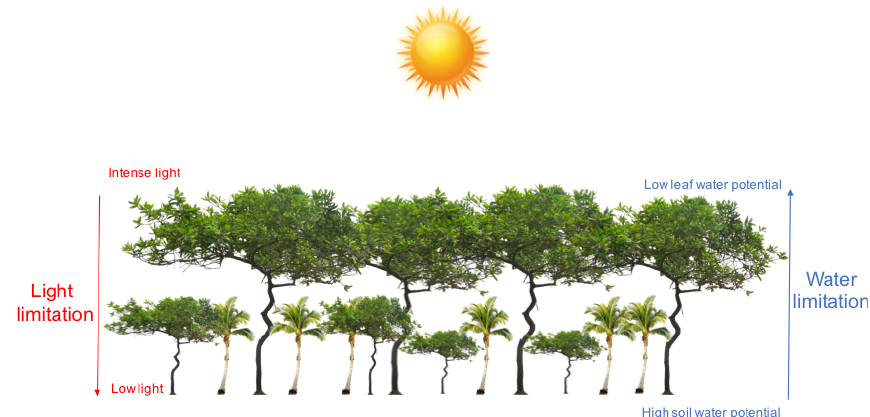
Figure 10. Schematic showing the vertical structure of light and water limitations in a tropical forest.